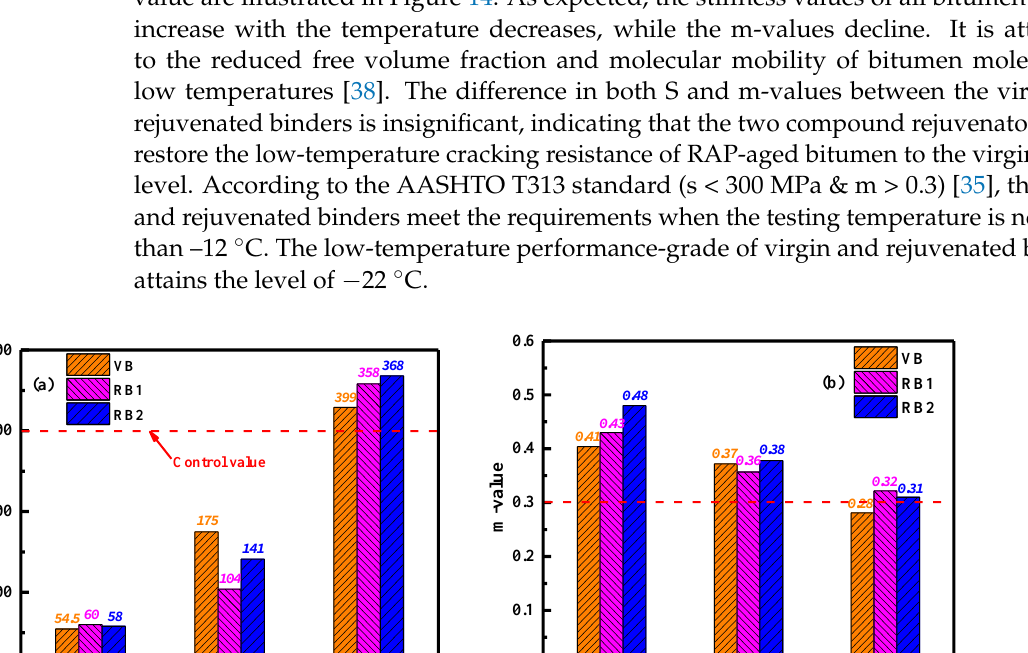
Figure 15. The rutting factor and PG grade of virgin and rejuvenated bitumen.